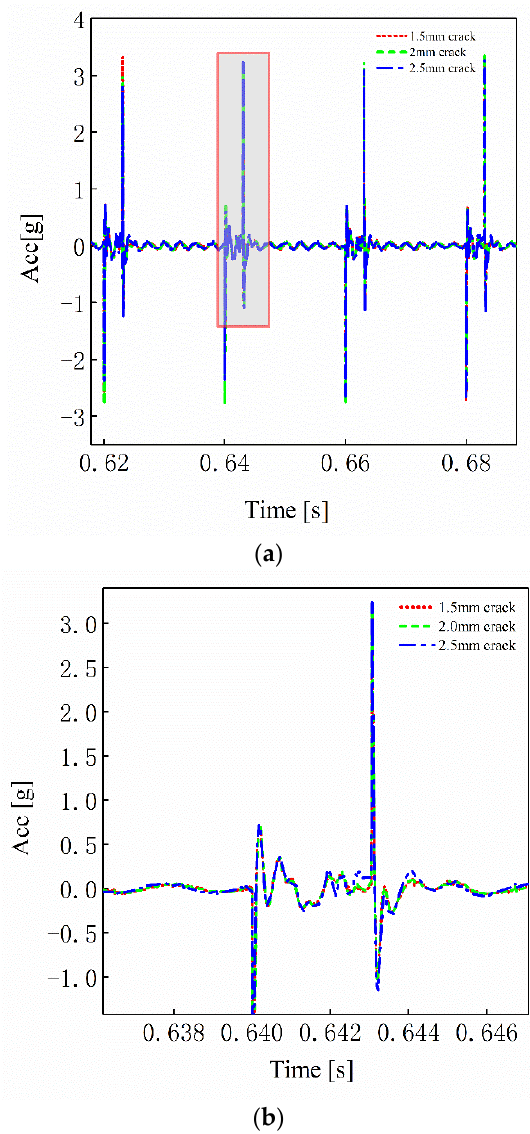
Figure 21. The residual signal of vibration acceleration with different crack depths. ( a ) The whole. ( b ) Zoomed plot.